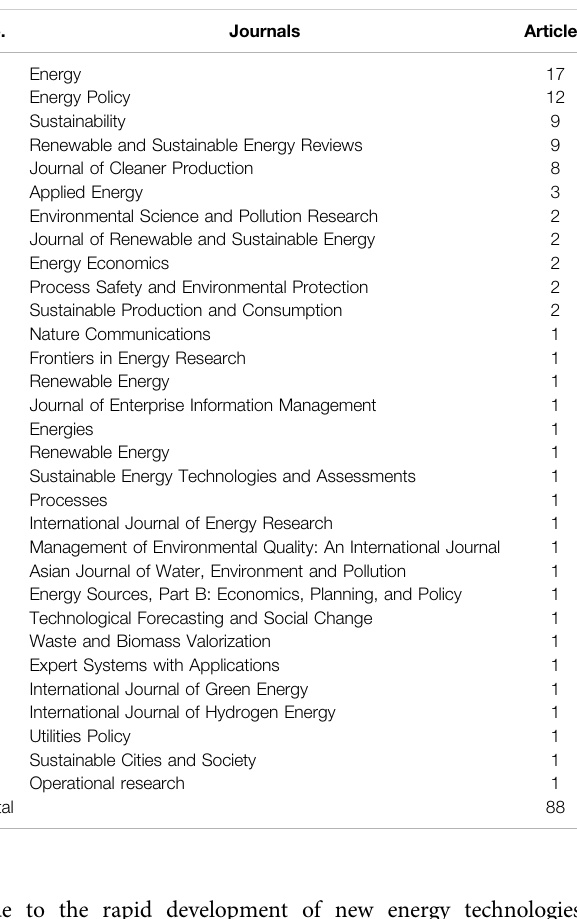
TABLE 2 | Journals ranked by number of articles.